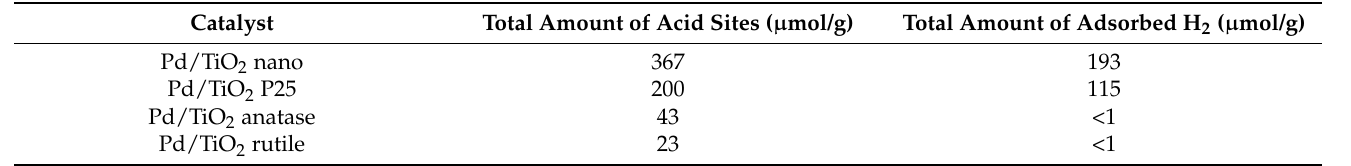
Figure 5. Selectivity to the different groups of products for TiO 2 -supported Pd catalysts at 35–40% conversion. Reaction conditions: 0.5 g of tars-type compounds, 4 g of n-hexadecane, 0.2 g of catalyst, at 250 °C and 30 bar of H 2 during 7 h. Table 3. Quantitative data for NH 3 -TPD and H 2